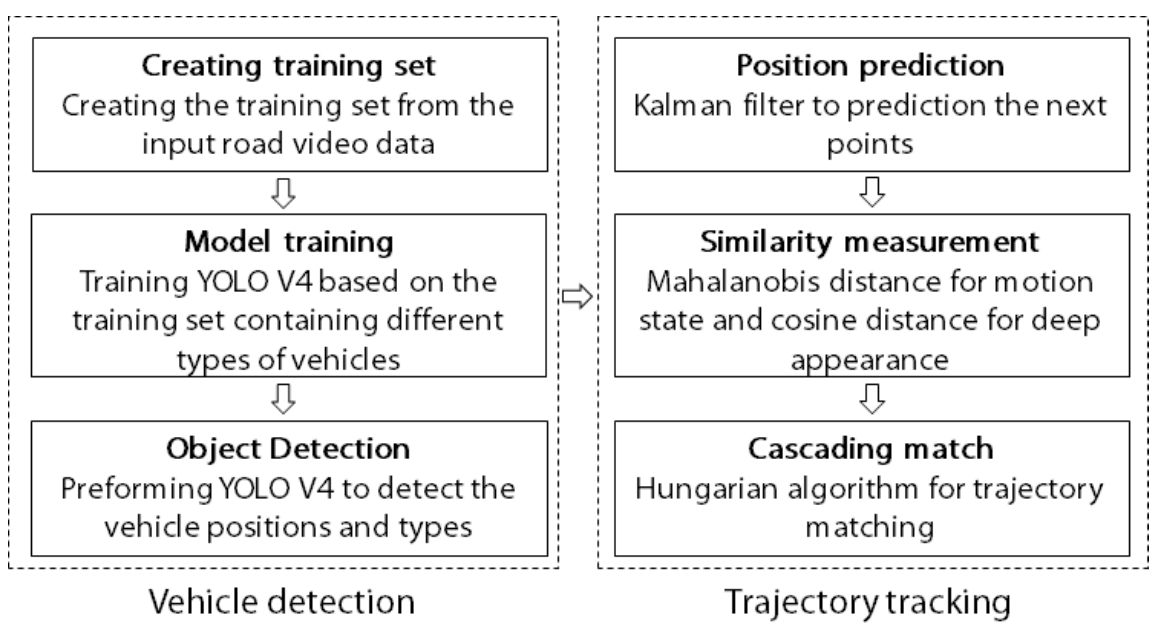
Figure 4. Processing of extracting dynamic traffic elements based on road video data.